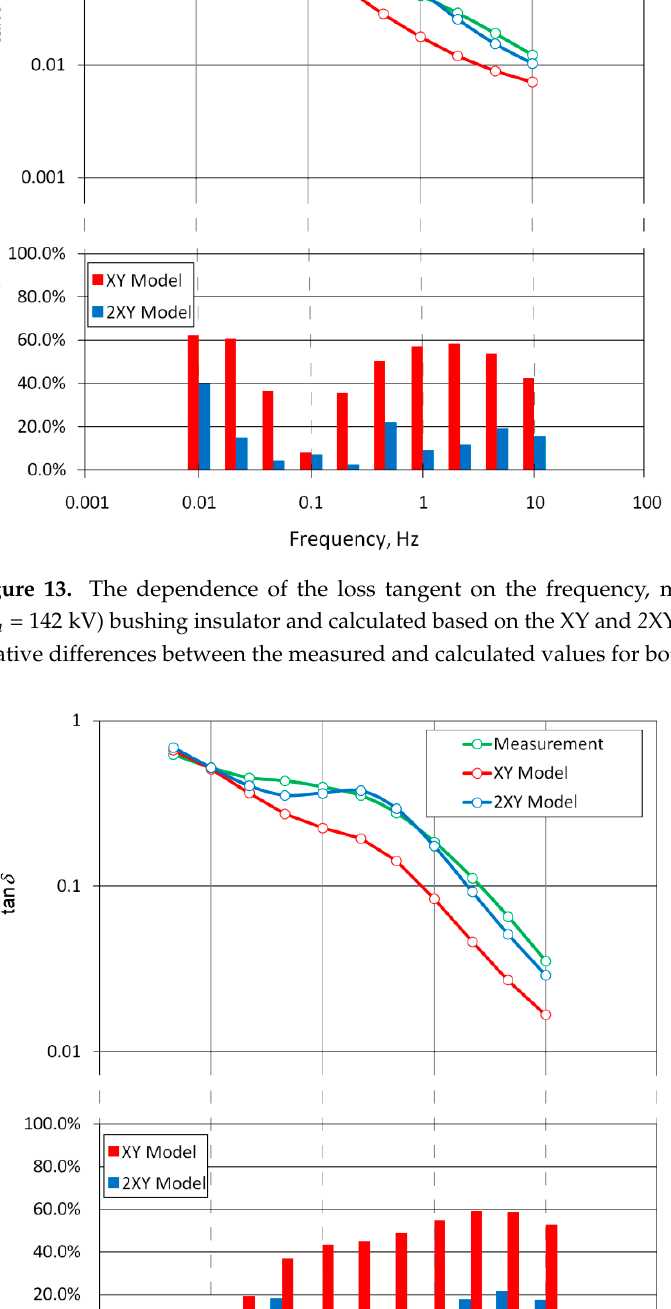
Figure 15. The dependence of the loss tangent on the frequency, measured for the COT type ( U n = 220 kV) bushing insulator and calculated based on the XY and 2 XY models, with the calculated relative differences between the measured and calculated values for both models.